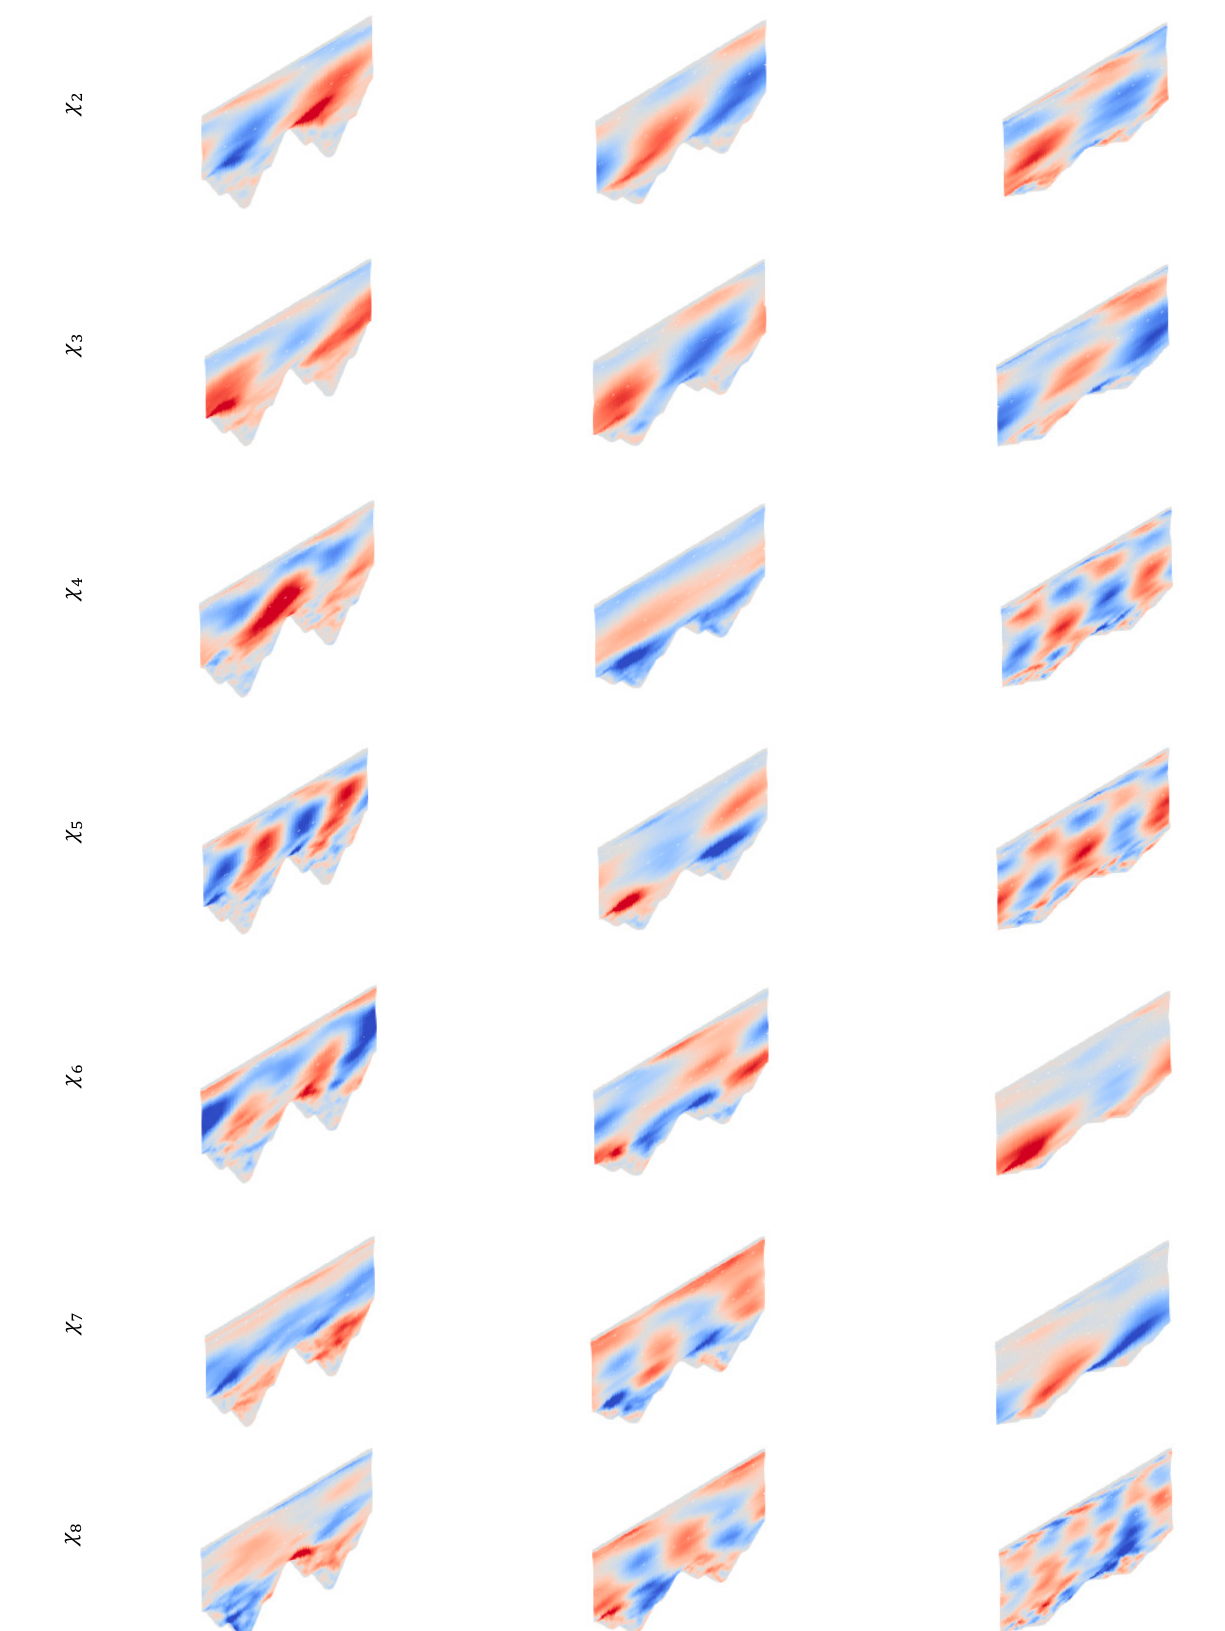
Figure 8. The first eight EPOD modes of the stream-wise velocity corresponding to the three levels of roughness height.